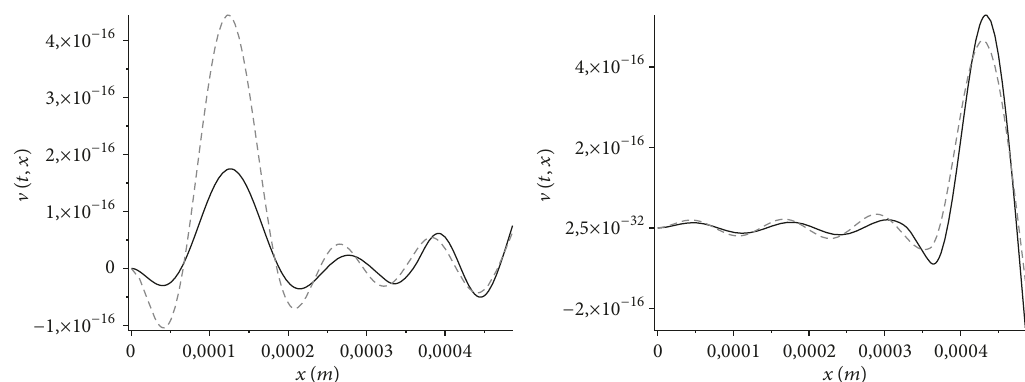
Figure 3: Left: forced response v ( t , x ) with fixed 𝑡 for f 1 ( x ) = sin (𝜔 t )( u ( x − a )− u ( x − b )) , 𝑎 = 100×10 −6 𝑚 , and 𝑏 = 150×10 −6 𝑚 . Right: forced response V (𝑡, 𝑥) with fixed 𝑡 for 𝑓 3 (𝑡, 𝑥) = sin (𝜔𝑡)(𝑢(𝑥 − 𝑐) − 𝑢(𝑥 − 𝑑)) , 𝑐 = 430 × 10 −6 𝑚 , and 𝑑 = 440 × 10 −6 𝑚 . Solid black line: beam with piezoelectric layer. Dashed gray line: beam without piezoelectric layer.